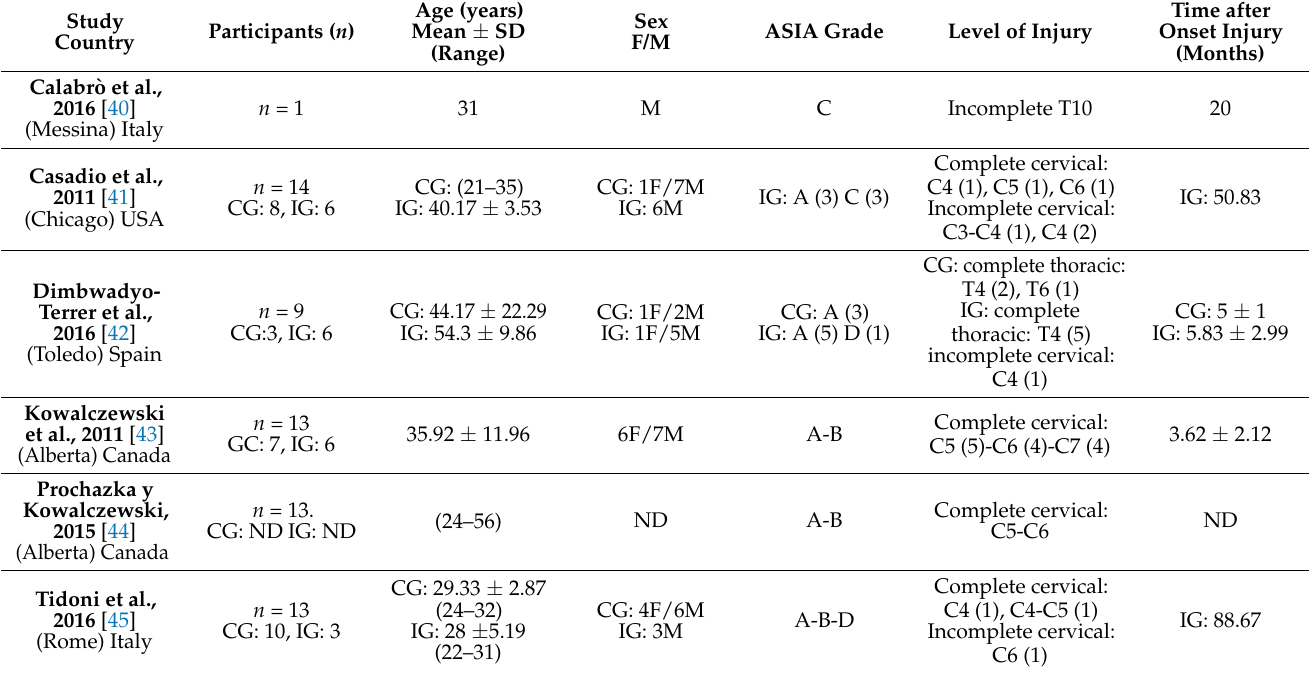
Table 1. Demographic and clinical characteristics of the